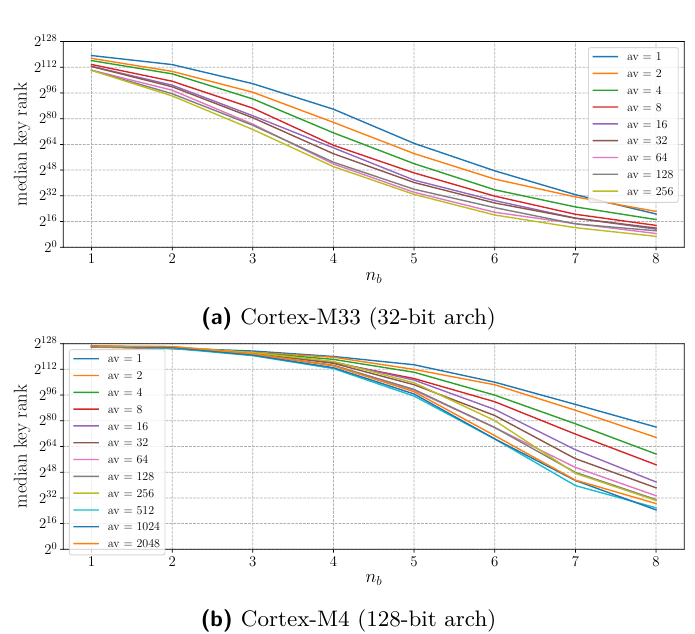
Figure 6: Median key rank of the Medwed et al. LR-PRF for various data complexities. Medians are estimated on 100 independent attacks with random